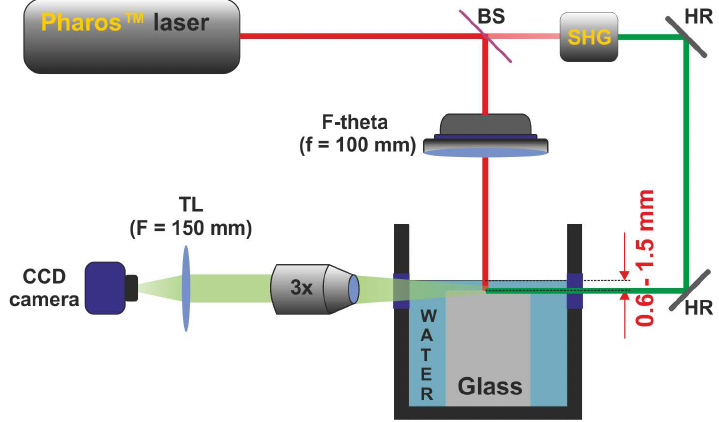
Figure 2. Shadowgraphy setup. Abbreviations: BS—beam splitter, HR—high reflectivity mirror, SHG—crystal for second harmonic generation, TL—tube